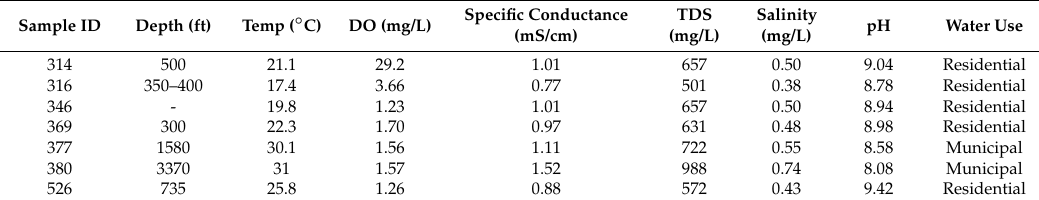
Table 1. Basic water quality analysis result and target use of water well investigated in this